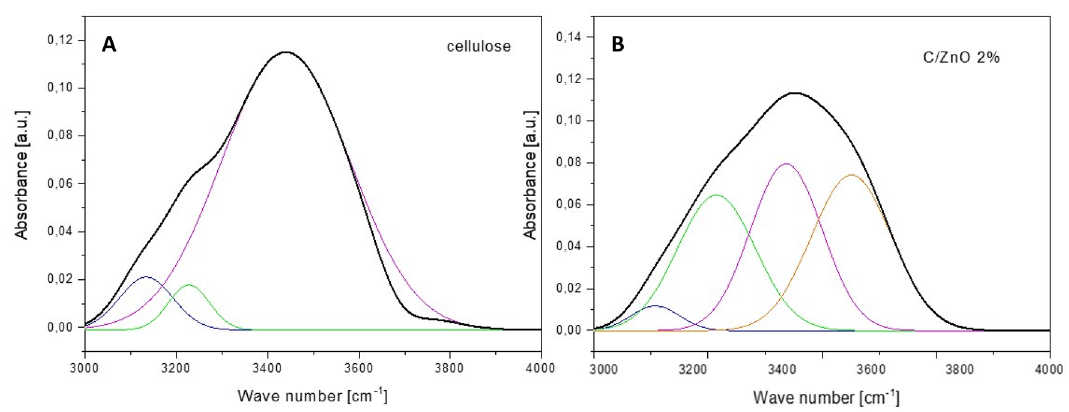
Figure 7. Deconvoluted spectra of the 3000–4000 cm −1 regions for raw cellulose fibers ( A ) and cellulose fibers functionalized with 2 wt% of ZnO particles ( B